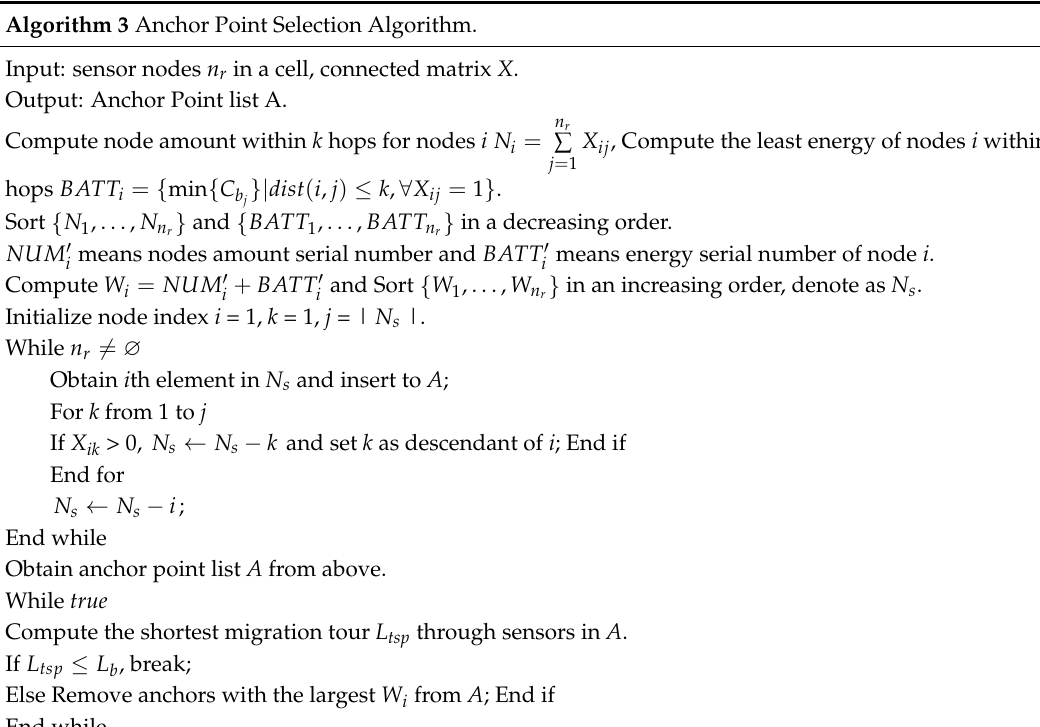
Algorithm 3 Anchor Point Selection